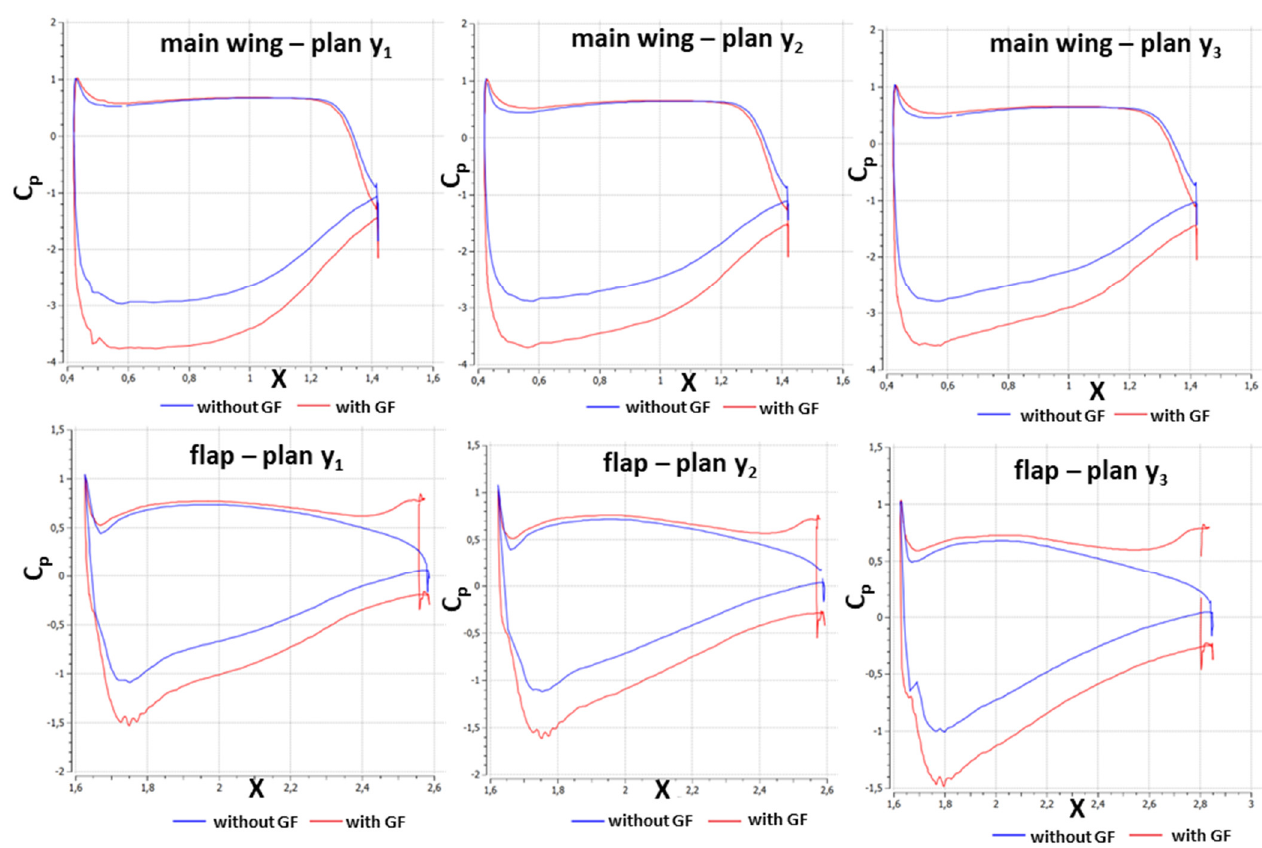
Figure 18. Pressure coefficients on wing ( upper ) and flap ( lower ) sections on plans y 1 , y 2 and y 3 with (red lines) and without (blue lines) GF.